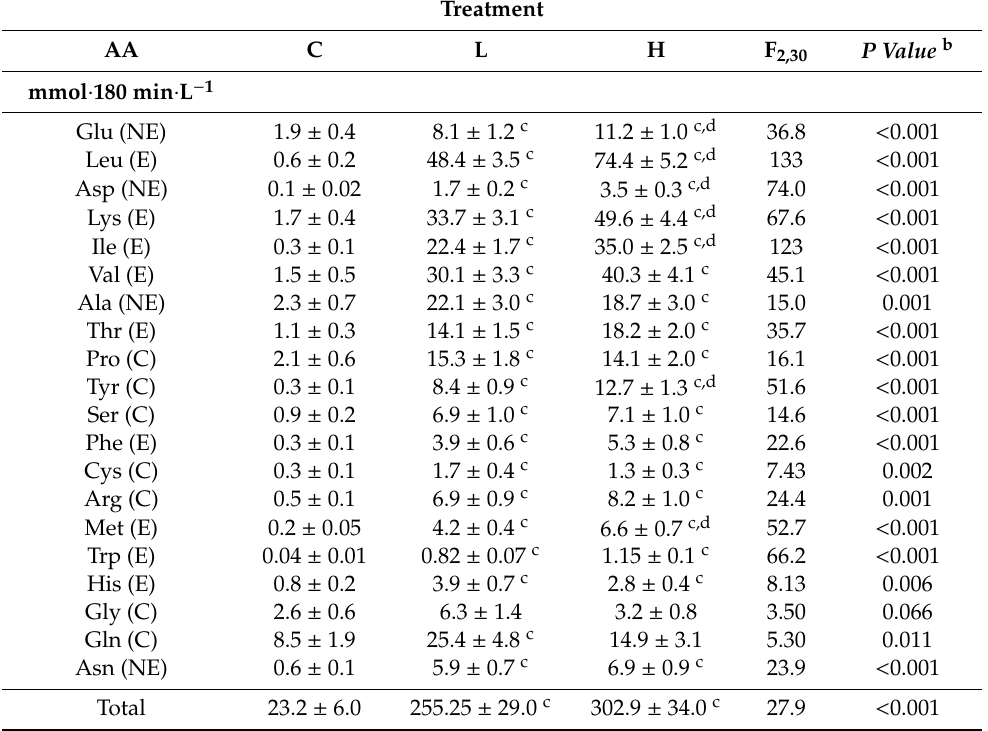
a Data are means ± SEMs, n = 16. b Main e ff ect of treatment on the iAUC 0–180min for individual AAs was determined by one-way repeated measures ANOVA and post-hoc comparisons between two loads were determined